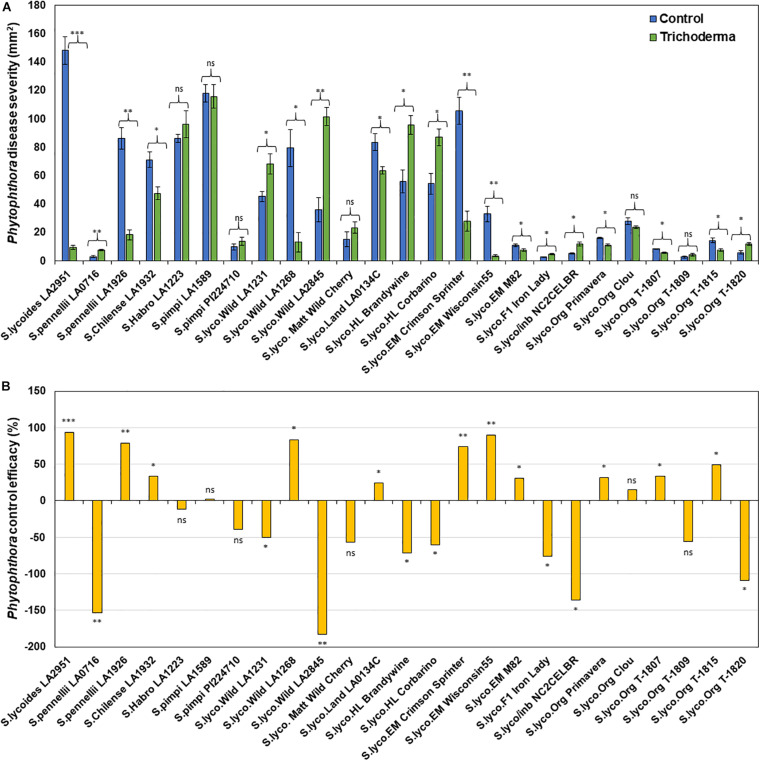
Effect of Trichoderma treatment on plant resistance against Phytophthora infestans in a diverse set of tomato genotypes (A). Graph (B) represents control efficacy of Trichoderma against P. infestans in comparison with the control treatment. Asterisks indicate significant differences in disease severity in the Trichoderma-treated versus control plants using the Student’s t-test at a ∗P ≤ 0.05, ∗∗P ≤ 0.01 and ∗∗∗P ≤ 0.001. Bars represent the standard error.